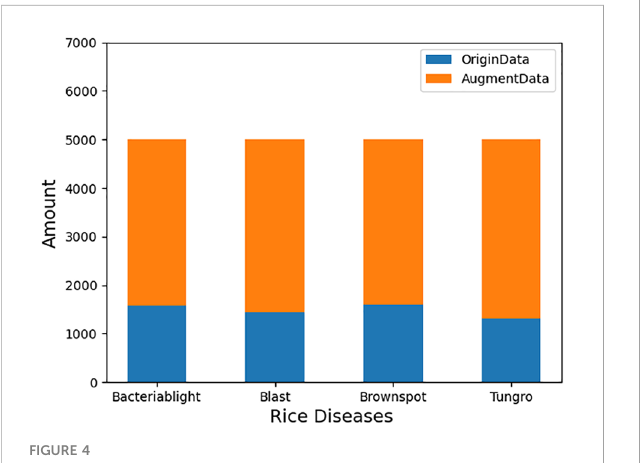
FIGURE 4 Augmented dataset distribution.